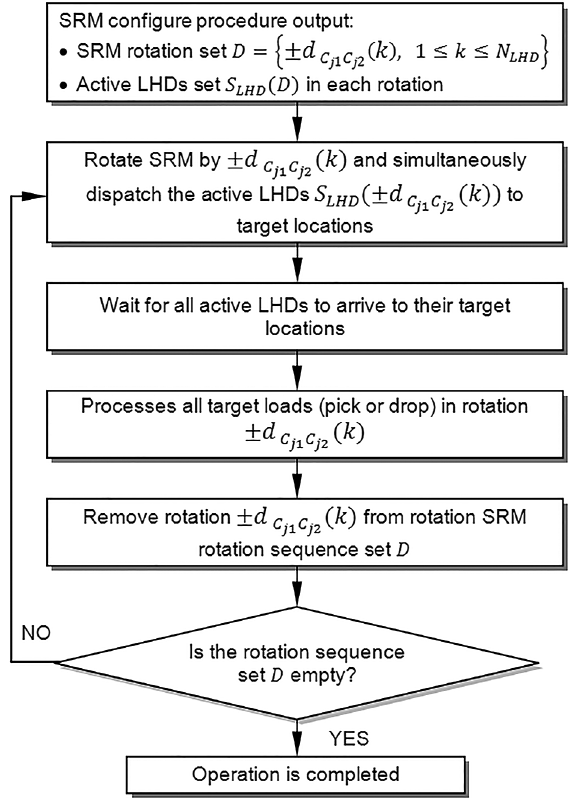
Fig. 5. Application of the SRM routing procedure